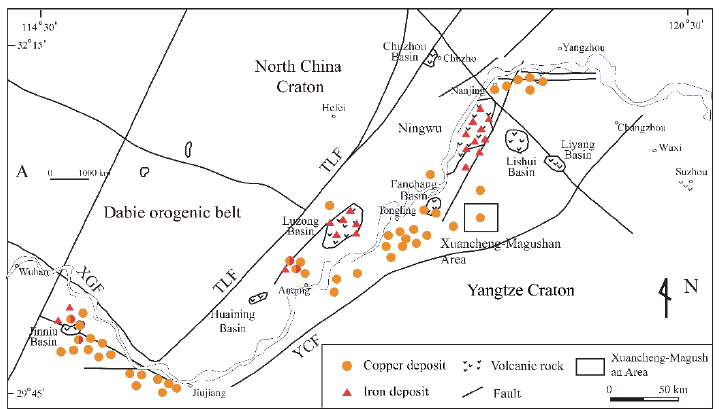
Figure 2. The location of Xuancheng – Magushan Area, volcanic basins, and ore concentration areas (OCAs) within the middle and lower Yangtze River Metallogenic Belt as well as the location of major settlements, faults, and major tectonic features. (Modified from Chang et al. [41], Mao et al. [42], and Ye. [43]).